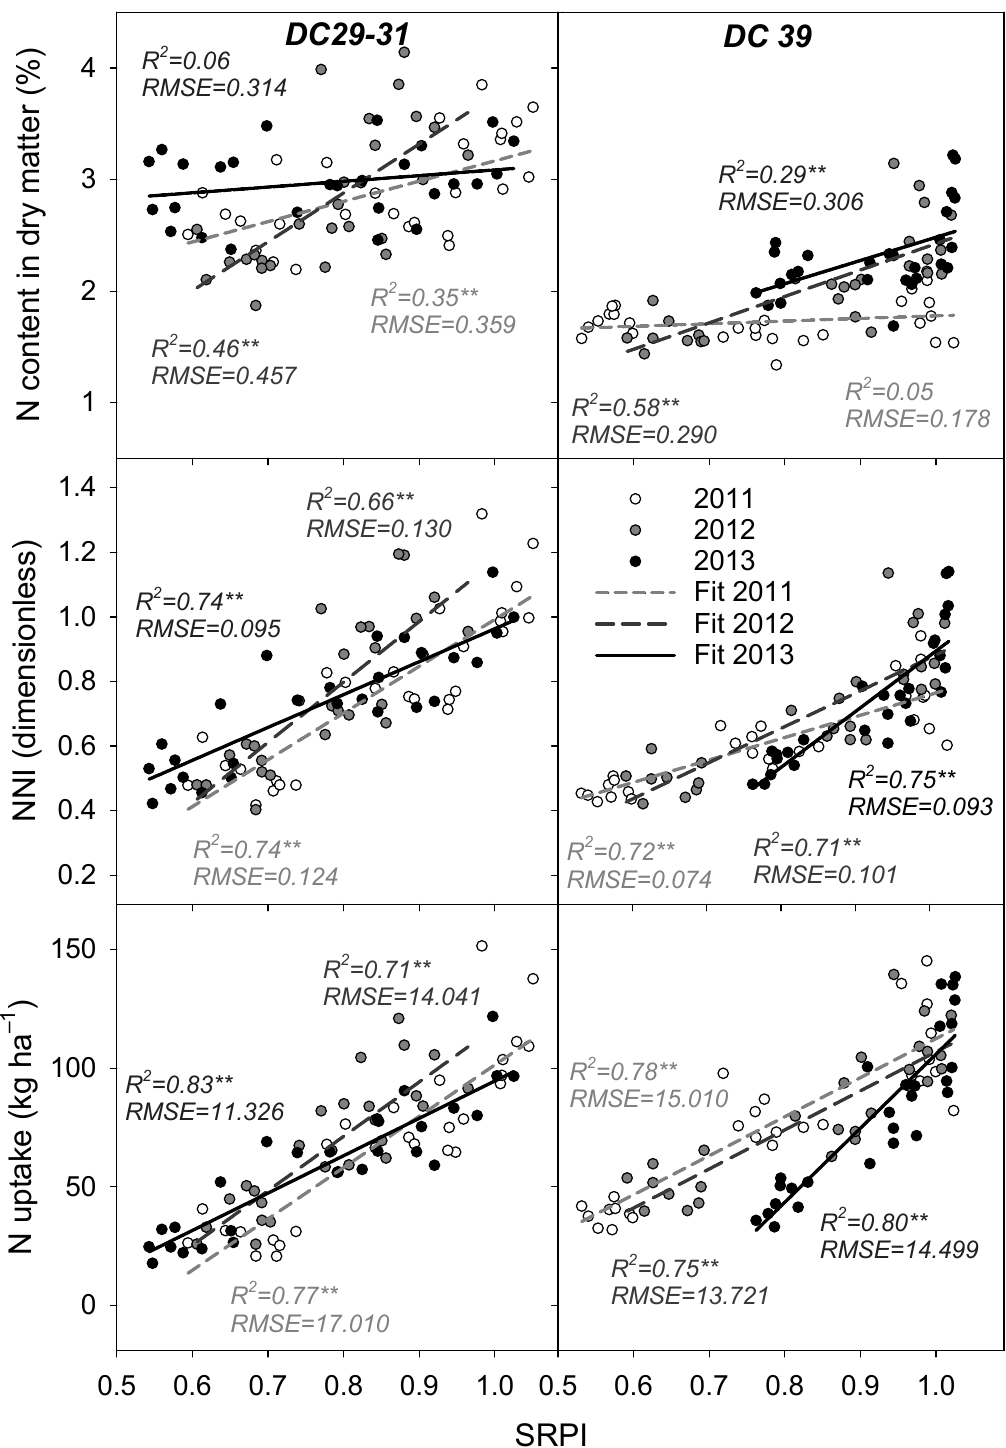
Figure 4. Linear relationships between reflectance index SRPI and nitrogen content in aboveground dry mass ( upper ), nitrogen nutrition index (NNI, middle ), and nitrogen uptake by aboveground biomass per area unit ( lower ), analyzed separately for growth stage beginning of stem elongation (DC 29–31, left ) and end of stem elongation (DC 39, right ), and for individual years (2011—white points and light grey line, 2012—grey points and dark grey line, and 2013—black points and black line). Coefficients of determination ( R 2 ), root mean square errors (RMSE), and significant correlations (* at p < 0.05 and ** at p < 0.01) are indicated for each relationship.